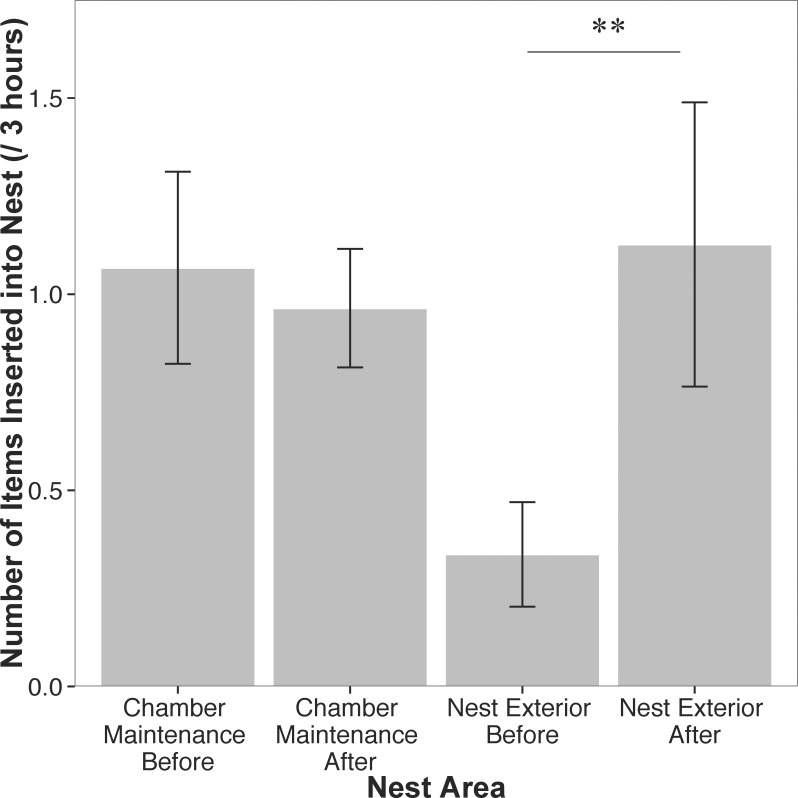
Mean number of items inserted into the nest.Left two bars represent items inserted into the nest chamber before and after aggression, respectively. The right two bars represent the number of items inserted into the nest thatch before and after aggression, respectively. There is a significant increase in items inserted into the nest thatch after an individual suffers aggression. Error bars represent ± 1 S.E.M.